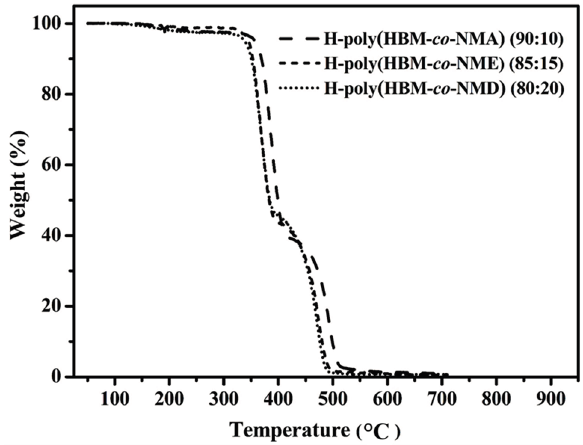
Figure A9. Thermogravimetric analyses of compolymers of HBM with different comonomers in air.